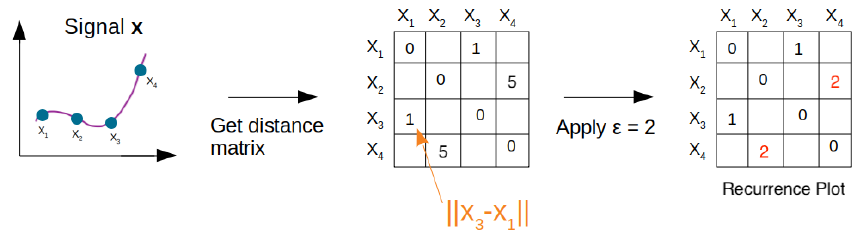
Figure 7. Generation of recurrence plot from a signal with fixed (cid:101) = 2.